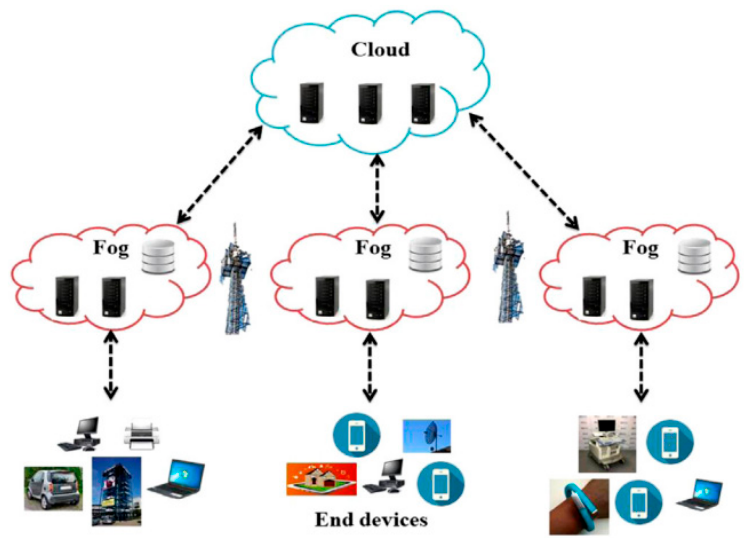
Figure 1. The IoT-fog-cloud network structure.